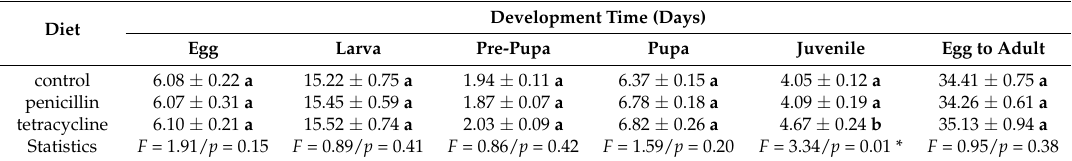
Table 2. Developmental time in days (Mean ± SE) for life stages of the coffee berry borer Hypothenemus hampei reared in artificial diet with and without antibiotics.